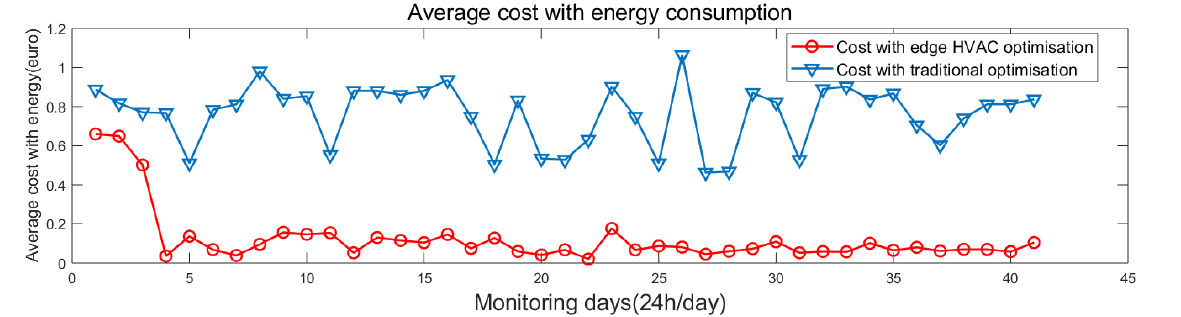
Figure 5. Thermal energy costs: Manual vs. Edge HVAC